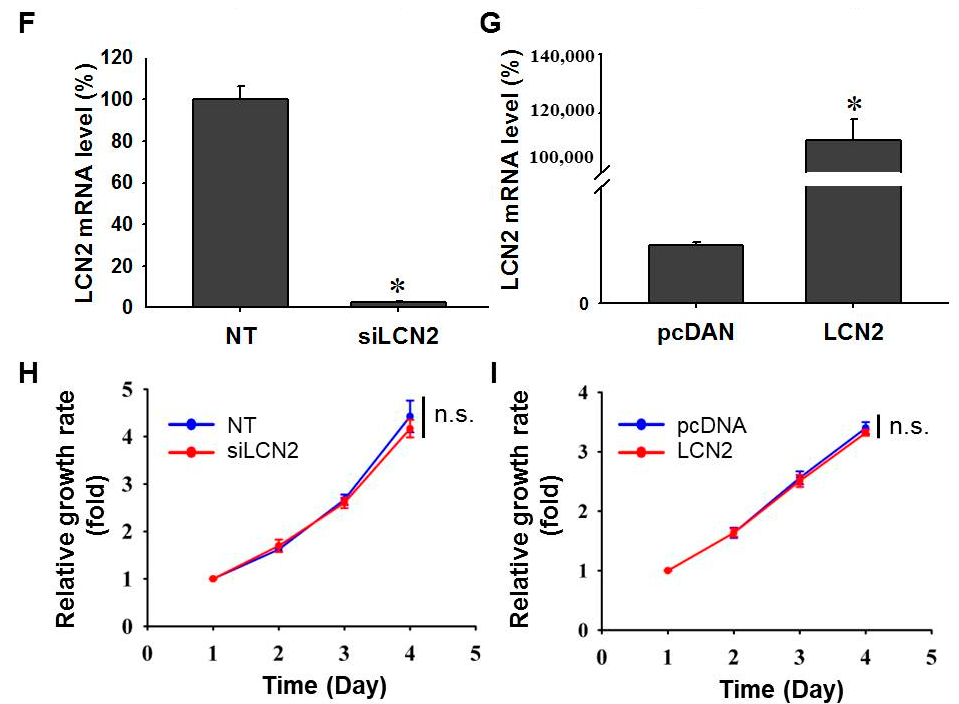
Figure 1. LCN2 did not affect cell growth of human NPC cells. ( A ) Bioinformatics analysis of LCN2 mRNA levels in normal and tumor tissues. ** p < 0.05. ( B ) LCN2 mRNA and protein levels in three human NPC cell lines, where HONE-1, NPC-39 and NPC-BM, were determined using RT-PCR and Western blot (WB) analysis. ( C ) LCN2 mRNA levels in three human NPC cell lines were examined using real-time qPCR analysis. ( D ) LCN2 protein and mRNA levels in HONE-1 cells after transfection with siRNA against LCN2 (siLCN2) or control (NT) were examined. ( E ) LCN2 protein and mRNA levels in NPC-BM cells after transfection with control plasmids (pcDNA) or plasmids containing LCN2 (LCN2). ( F ) LCN2 mRNA level of HONE-1 cells after transfection as ( D ) was determined using real-time qPCR analysis. * p < 0.05 when compared with control (pcDNA). ( G ) LCN2 mRNA level of NPC-BM cells after transfection as ( E ) was determined using real-time qPCR analysis. ( H ) Cell growth of HONE-1 cells after transfection as ( D ) was determined for 4 days using an MTT assay. ( I ) Cell growth of NPC-BM cells after transfection as ( E ) was determined for 4 days using an MTT assay. n.s.: no significance, when compared with control.